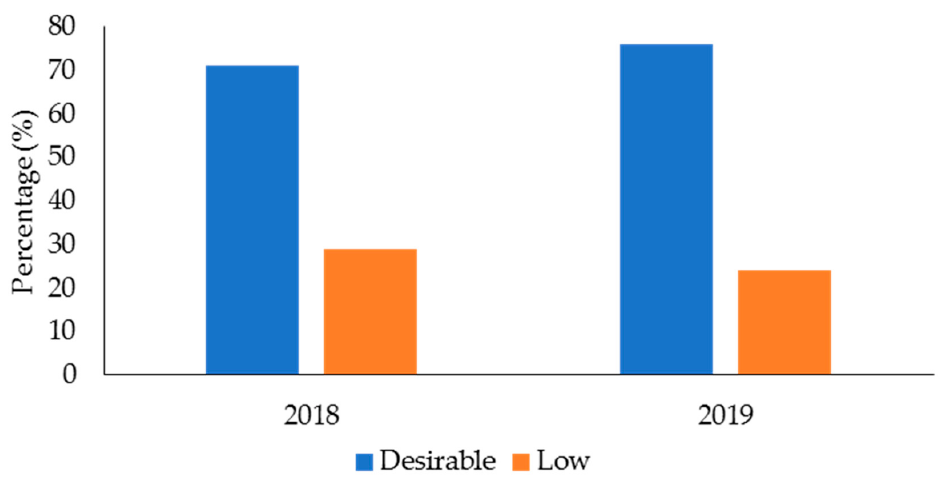
Figure 3. Percentage of police officers from a health and wellness program in 2018 and 2019 classified according to the categories for high-density lipoproteins.